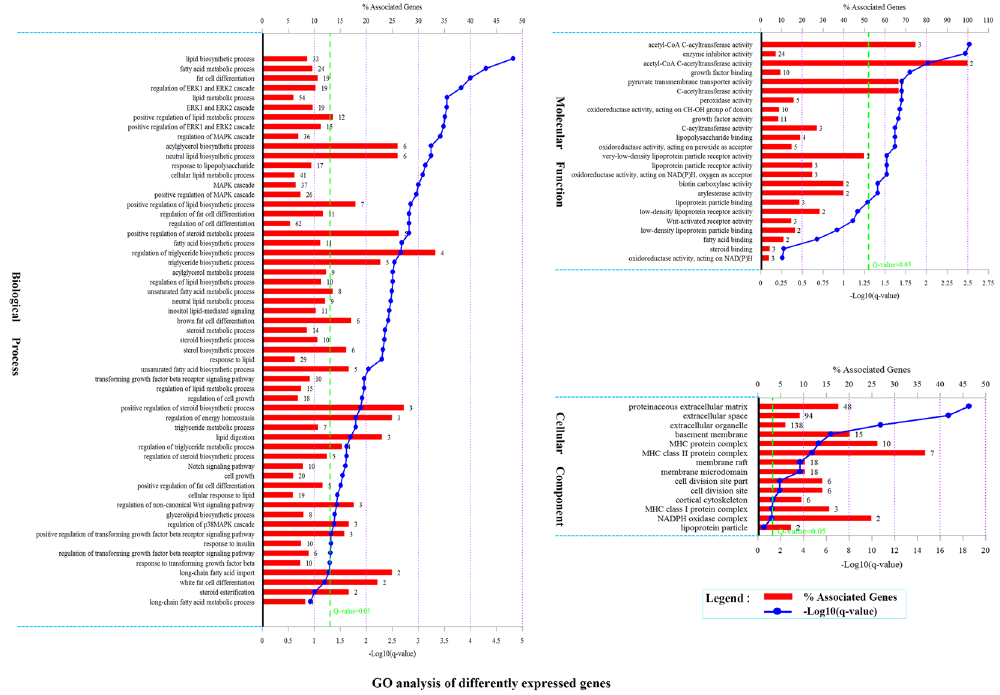
Figure 2. GO analysis of differentially expressed genes. The figure is composed of three parts: biological processes, molecular functions, and cellular components. The significance level of enrichment was set at corrected p_value (q_value) < 0.05.